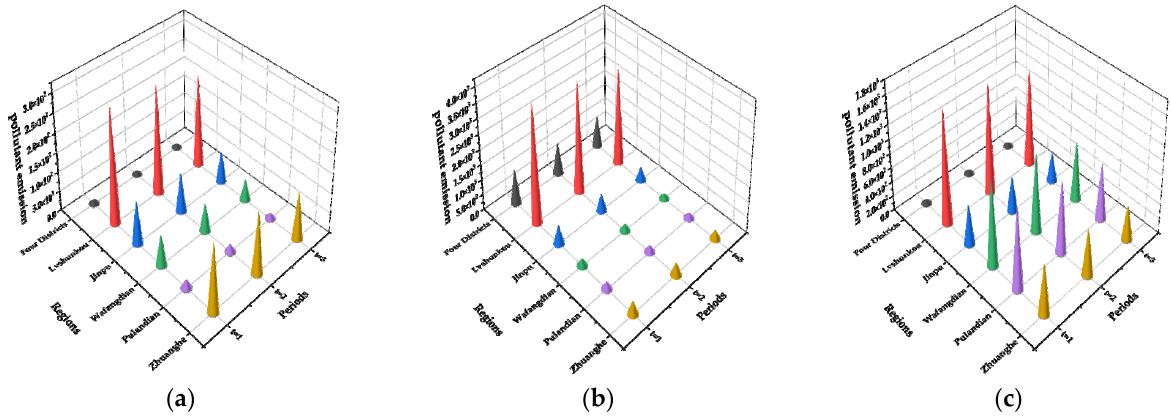
Figure 11. NH 3 -N emissions of various sectors: ( a ) industry; ( b ) municipal; ( c ) agriculture (tons/year).